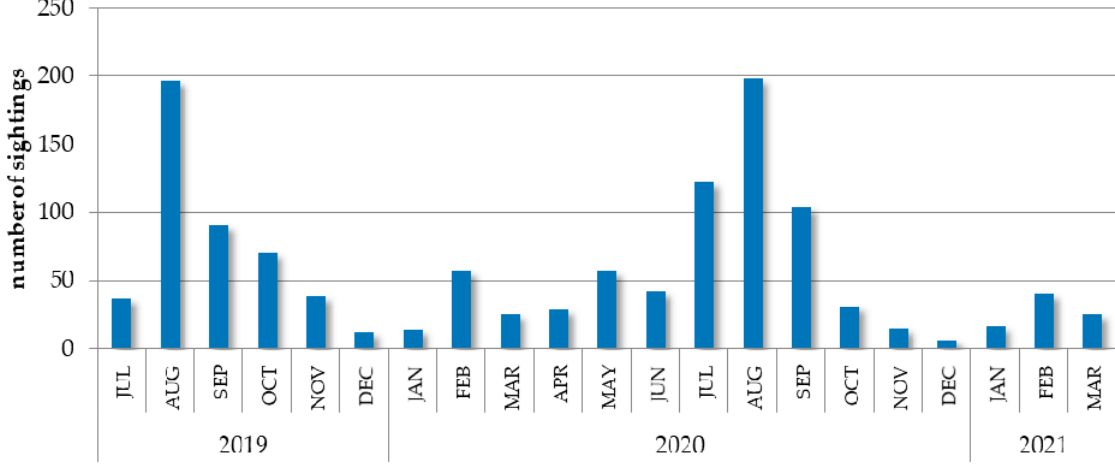
Figure 4. Monthly sightings from 12 July 2019 to 8 March 2021.